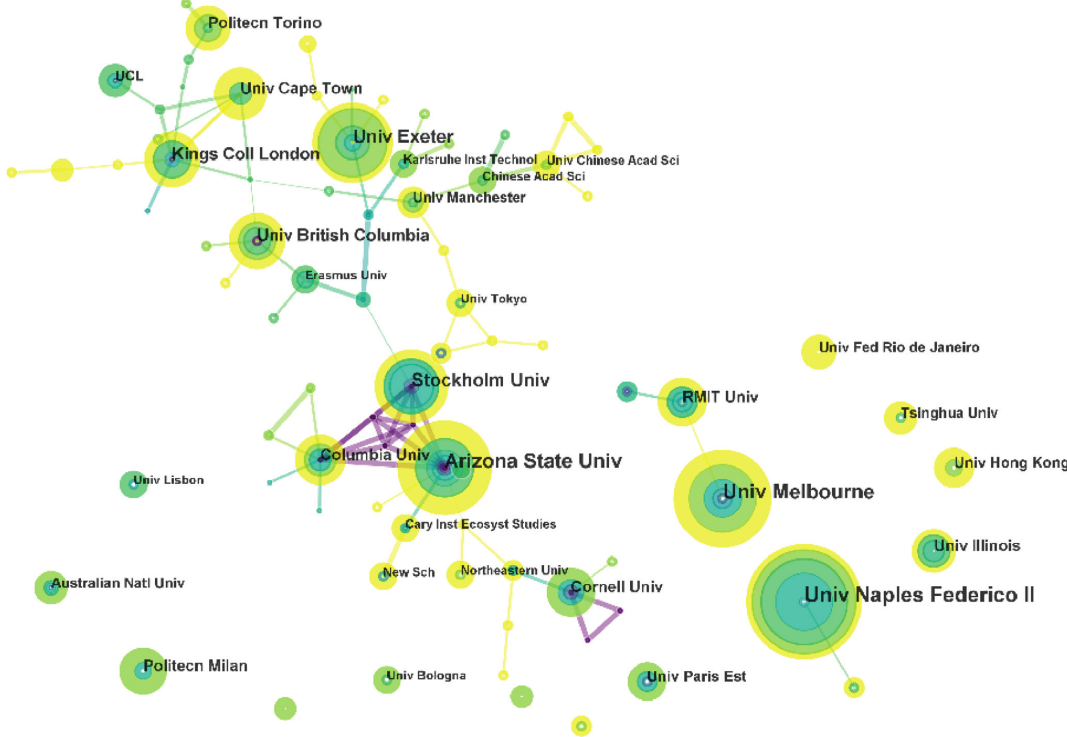
Figure 7: Visualization map of institution in resilient city research from 2010 to 2019. Table 3: Top 10 productive institutions according to publications.